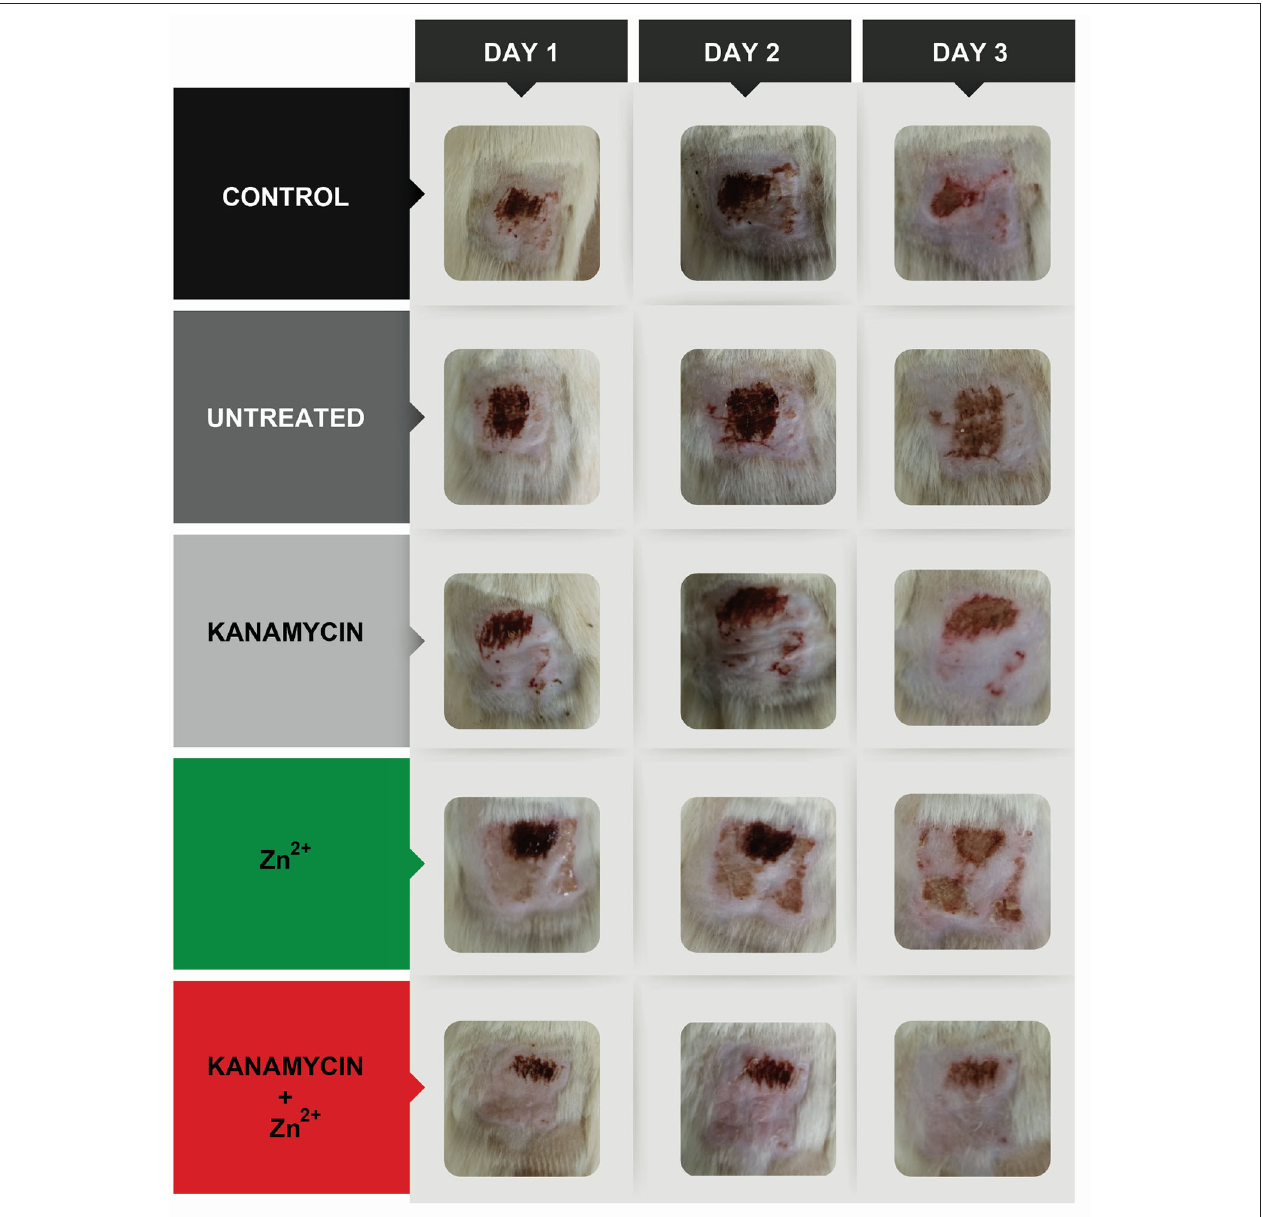
FIGURE 12 | In vivo topical infection model with S. aureus-Kan induced by a tape stripping model. Images show the evolution of the in vivo infection after 3 days in the control, an untreated infection and infections treated with Zn, kanamycin, and Zn-kanamycin combinations (all at 0.5 MIC).